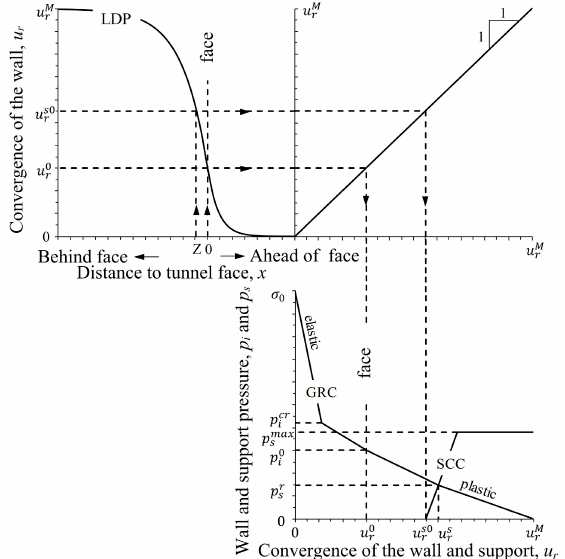
Figure 1. Schematic representation of the convergence-confinement method [8]. Reproduced with permission from Carranza-Torres C., Tunnelling and Underground Space Technology; published by Elsevier, 2000.